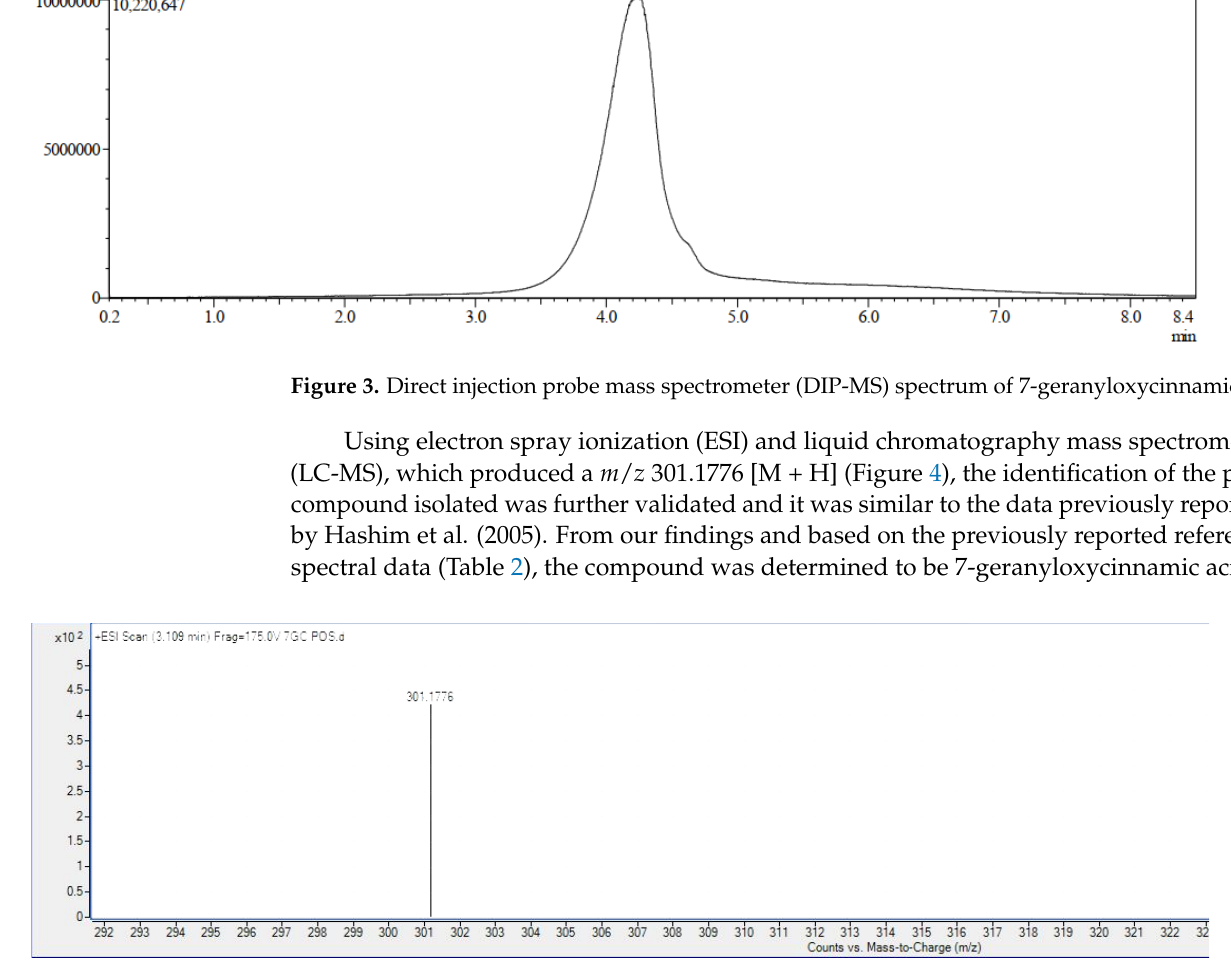
Figure 4. Mass spectrogram (ESI positive mode) of 7-geranyloxycinnamic acid.